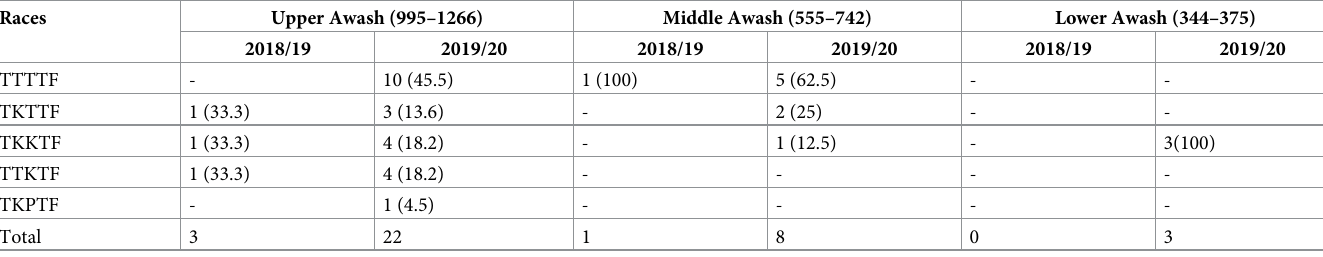
Table 5. The Pgt races climatic distribution in 2018/19 and 2019/20 cool seasons irrigated wheat areas. Races